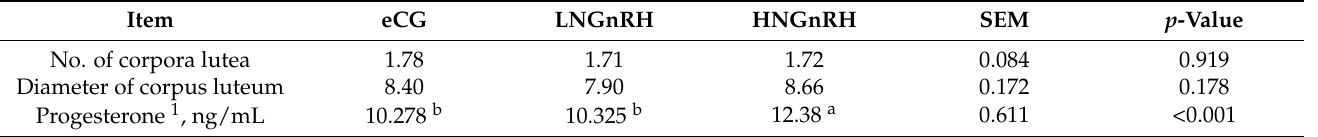
Table 1. Ovarian structures observed on day 7 post-mating and blood serum progesterone concentra- tions of ewes treated with equine chorionic gonadotropin (eCG, 350 IU/ewe) during CIDR removal or under different doses of nanoencapsulated gonadotropin releasing hormone (LNGnRH, 25 µ g/ewe and HNGnRH, 50 µ g/ewe) 48 h after CIDR removal (means ± standard error of means,